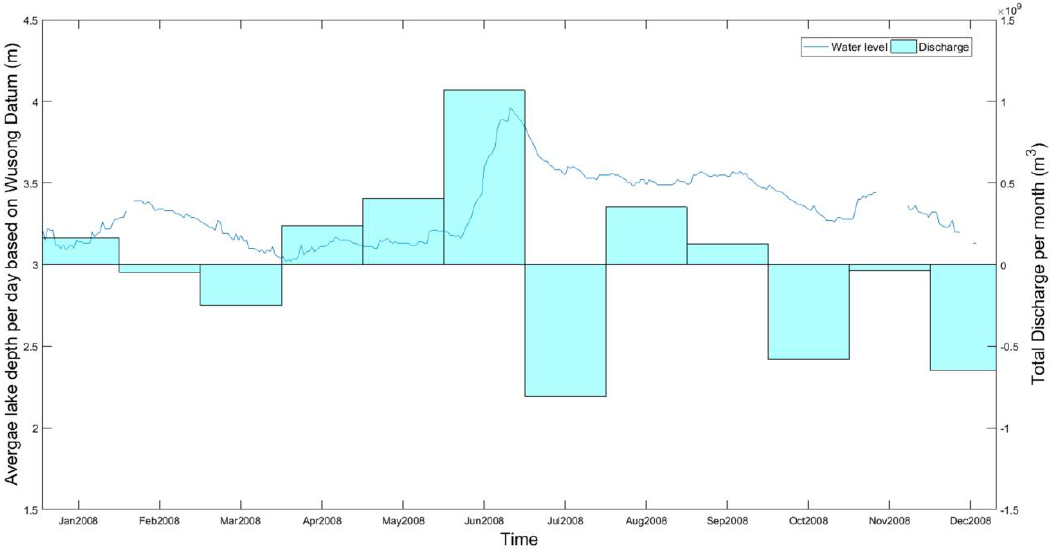
Figure 2. Monthly discharge data (bars, positive values represent inflow discharge) and average daily water level (blue line) of Taihu Lake in 2008.